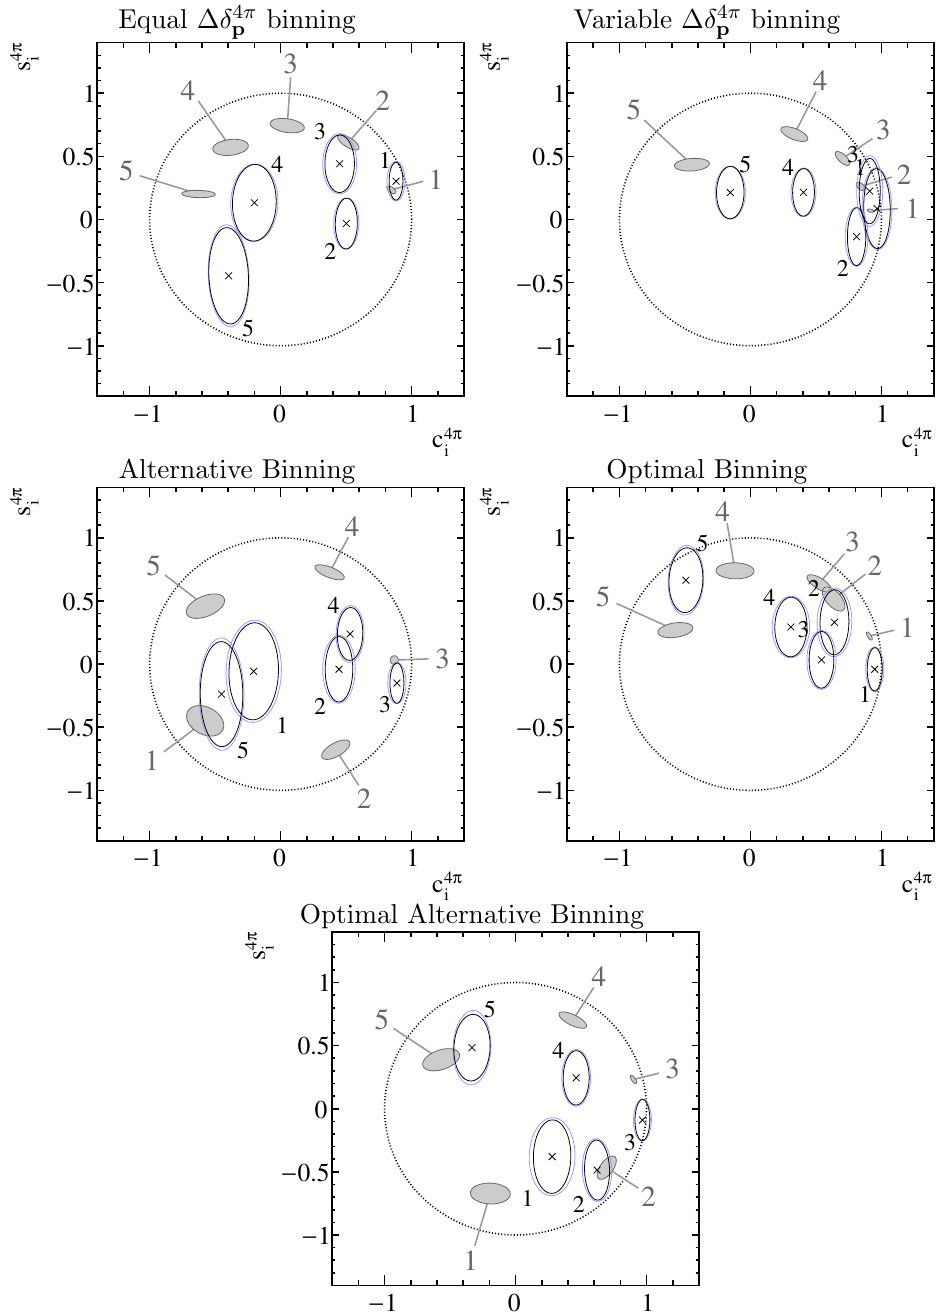
Figure 8 . Each (cid:12)gure shows the hadronic parameters c 4 (cid:25) 4 (cid:25) (cid:6) binning schemes discussed in section 4 where N = 5. The grey shaded ellipses give the model predictions and uncertainties discussed in section 4. The black (blue) ellipses show the measured values and statistical (statistical + systematic) uncertainties. In all cases the ellipse contains the 39 : 3% con(cid:12)dence region, de(cid:12)ned by the log L max (cid:0) log L = 1 is the maximum value of log L .